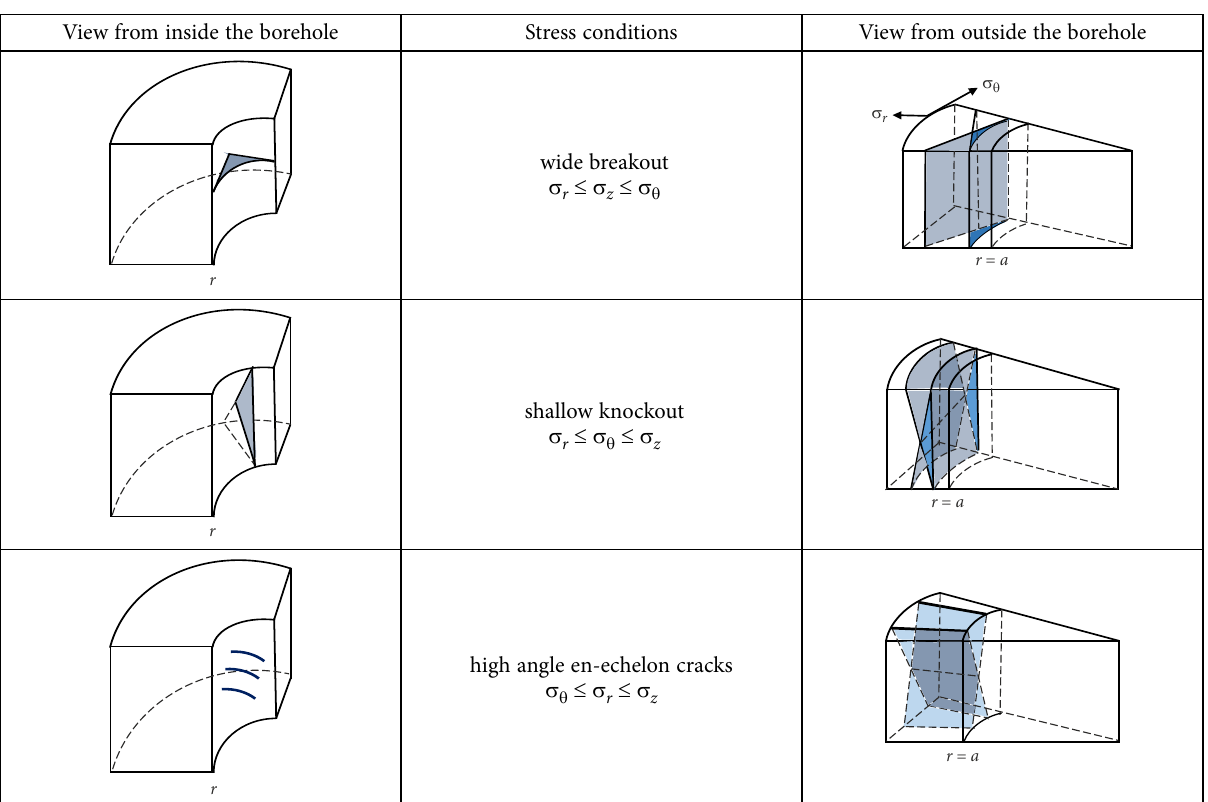
(Zang & Stephansson, 2010)